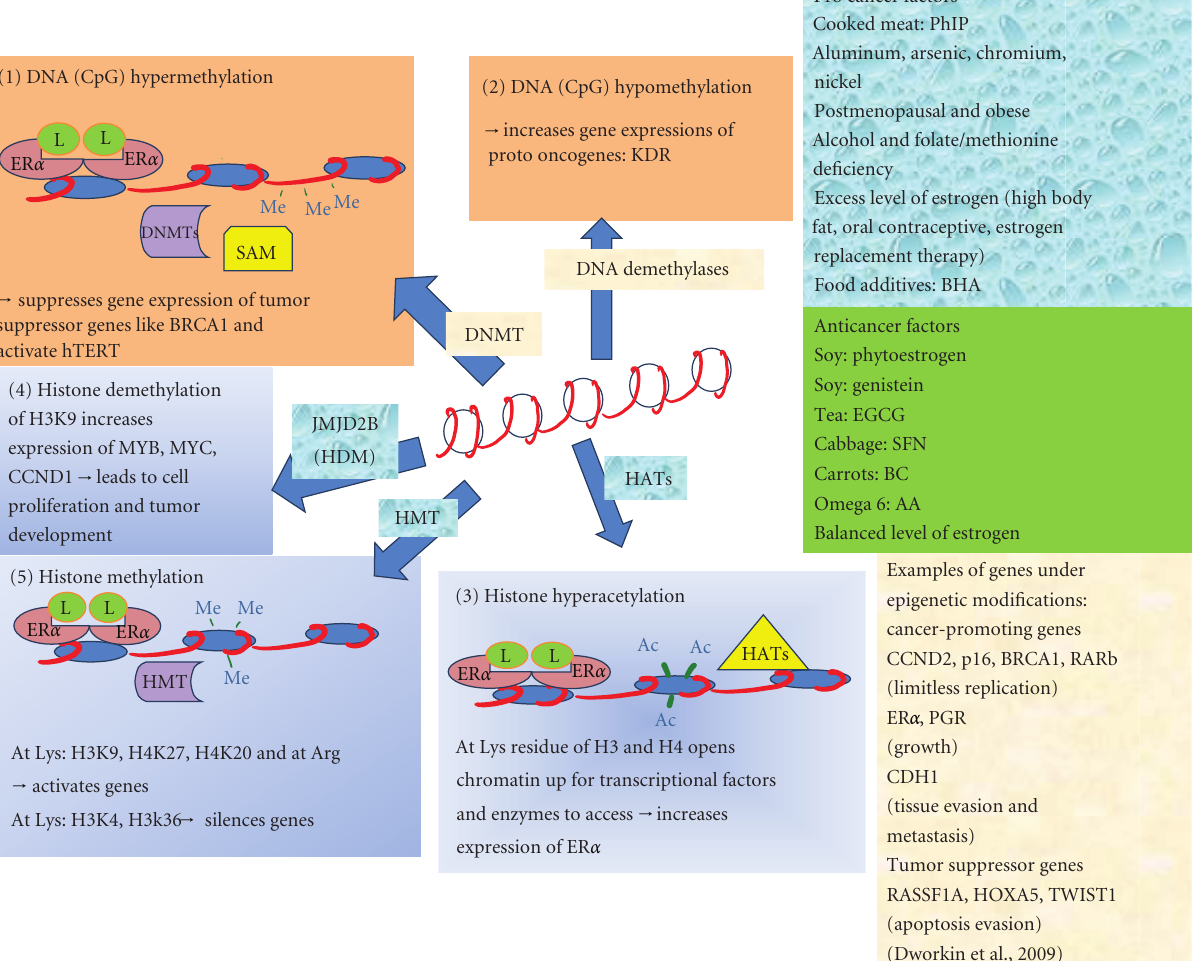
Figure 1: Five mechanisms for epigenetic alterations in breast cancers. Each alteration involves many enzymes but the main players to cause methylation or acetylation are shown by arrows. These are not separate mechanisms and the enzymes do not act alone. Several enzymes act at a promoter simultaneously. (1) Hypermethylation at the CpG islands found in estrogen response element (ERE) promoters. When ligand- (L-) bonded ER α dimerizes, the complex (L-ER α dimer) acts as transcription factor and binds to the ERE promoter. Ligands could be E2, phytoestrogen, PhIP, and so forth. The dimer may recruit DNMTs which catalyze the transfer of methyl groups from SAM to 5 (cid:2) -cytosine on CpG islands. (2) Other enzymes could be recruited to the region by L-ER α dimers which activate DNA demethylases to act simultaneously to increase gene expression of protooncogenes and genes involved in cell growth. (3) L-ER α dimer may also recruit SWI/SNF and HATs to the ERE promoter region. HATs include p160, CBP, p300, pCAF. (4) Histone demethylases such as JMJD2B and (5) histone methyltransferases (HMTs) are enzymes which acetylate lysine residues on H3 and or H4 to open up the chromatin for other transcription factors and enzymes. Enzymes/cofactors: DNA methyltransferases (DNMTs), s-adenosylmethionine (SAM), histone acetyltransferases (HATs), histone methylases (HDM) JMJD2B, histone methyltransferases (HMTs), and DNA demethylases (member of MBD, methyl CpG-binding domain, family